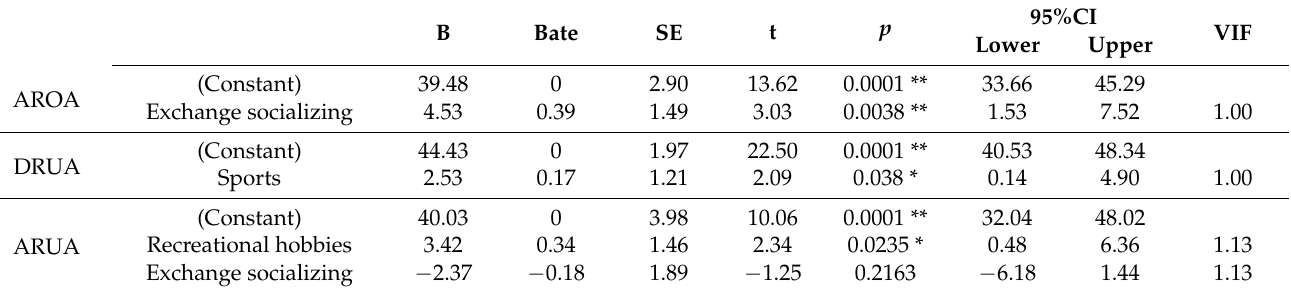
Table 4. Logistic regression results of the